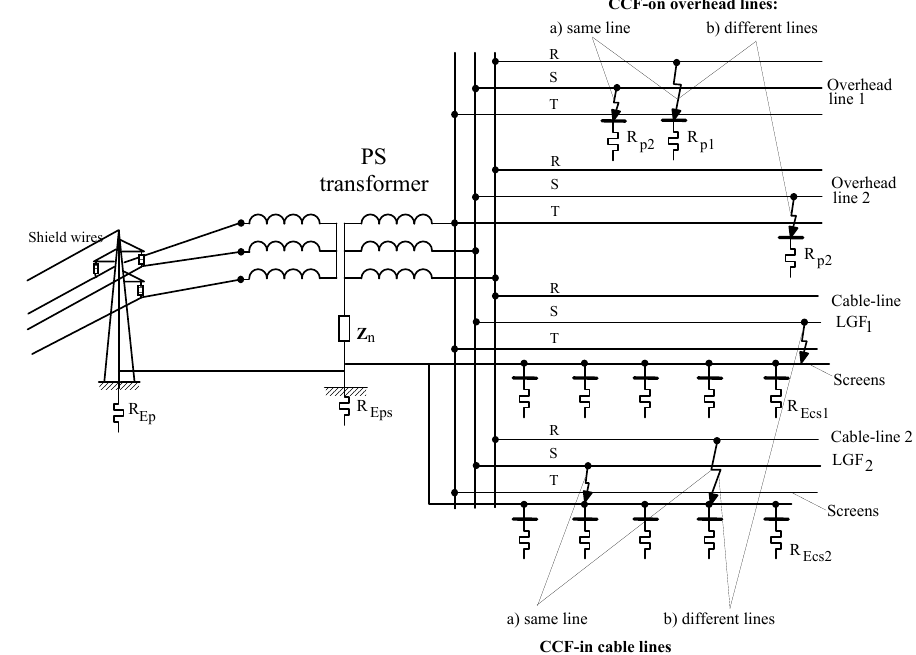
Figure 1. Medium voltage (MV) public distribution network with Cross-Country faults (CCFs) in different lines and locations.